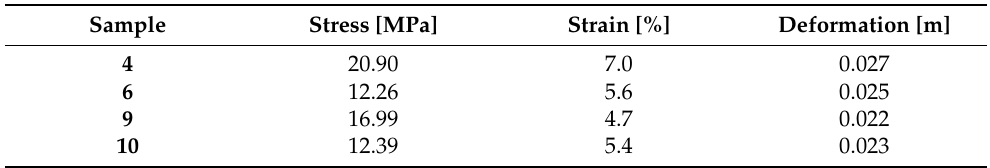
Table 7. The biggest representative (repetitive) values of stress, strain, and deformation based on the visual results;